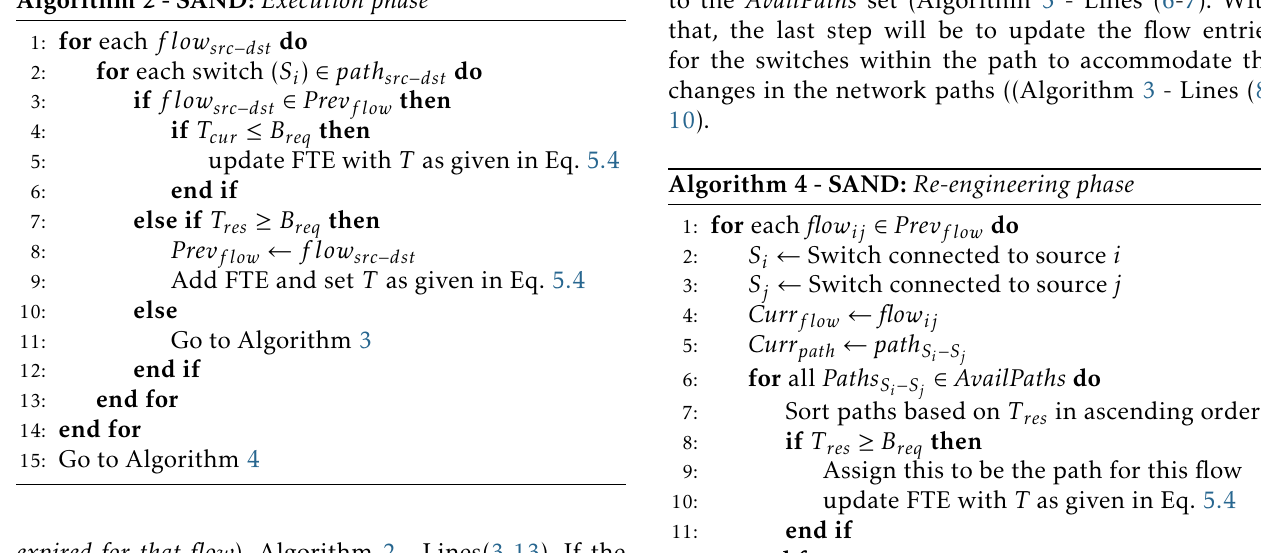
Algorithm 2 - SAND: Execution phase